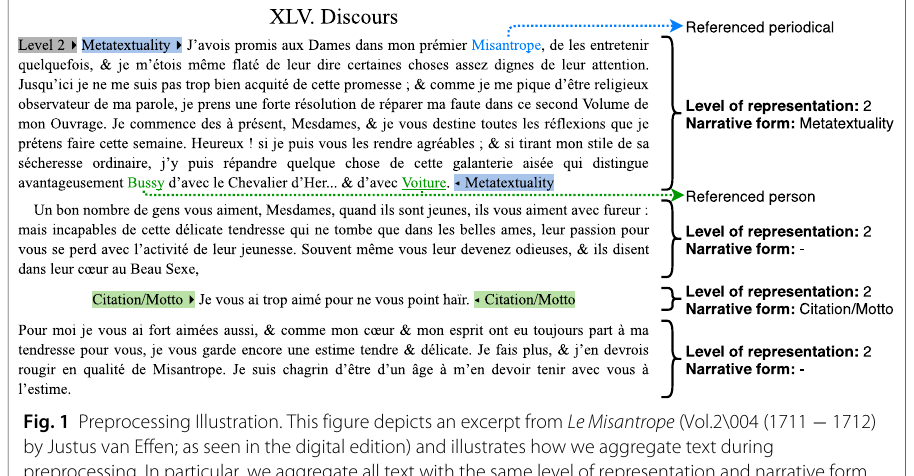
Fig. 1 Preprocessing Illustration. This figure depicts an excerpt from LeMisantrope (Vol.2\004 (1711 − 1712) by Justus van Effen; as seen in the digital edition) and illustrates how we aggregate text during preprocessing. In particular, we aggregate all text with the same level of representation and narrative form (indicated by colored labels) into text passages, respectively for each issue. In this example, we arrive at three text passages: One with level of representation 2 and narrative form Metatextuality (i.e., the first paragraph), one with level of representation 2 and narrative form Citation/Motto (i.e., the third paragraph), and one with level of representation 2 and no distinct narrative form (i.e., the second and fourth paragraph). Further, we extract mentioned periodicals (indicated with blue color), people (real or fictional; indicated with green color) and places (none in this excerpt) for our